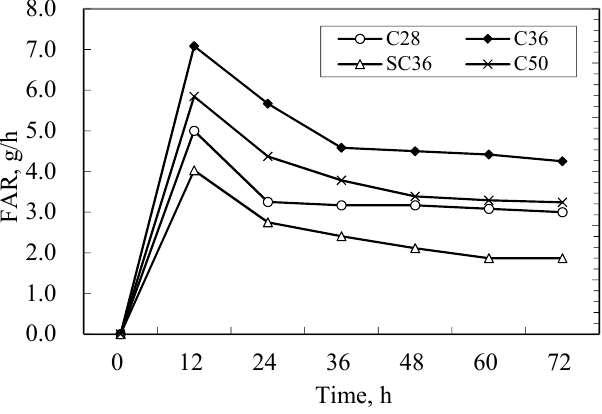
Figure 9. Friction abrasion rate (FAR) of concrete (SC36 with steel fibers, others without).